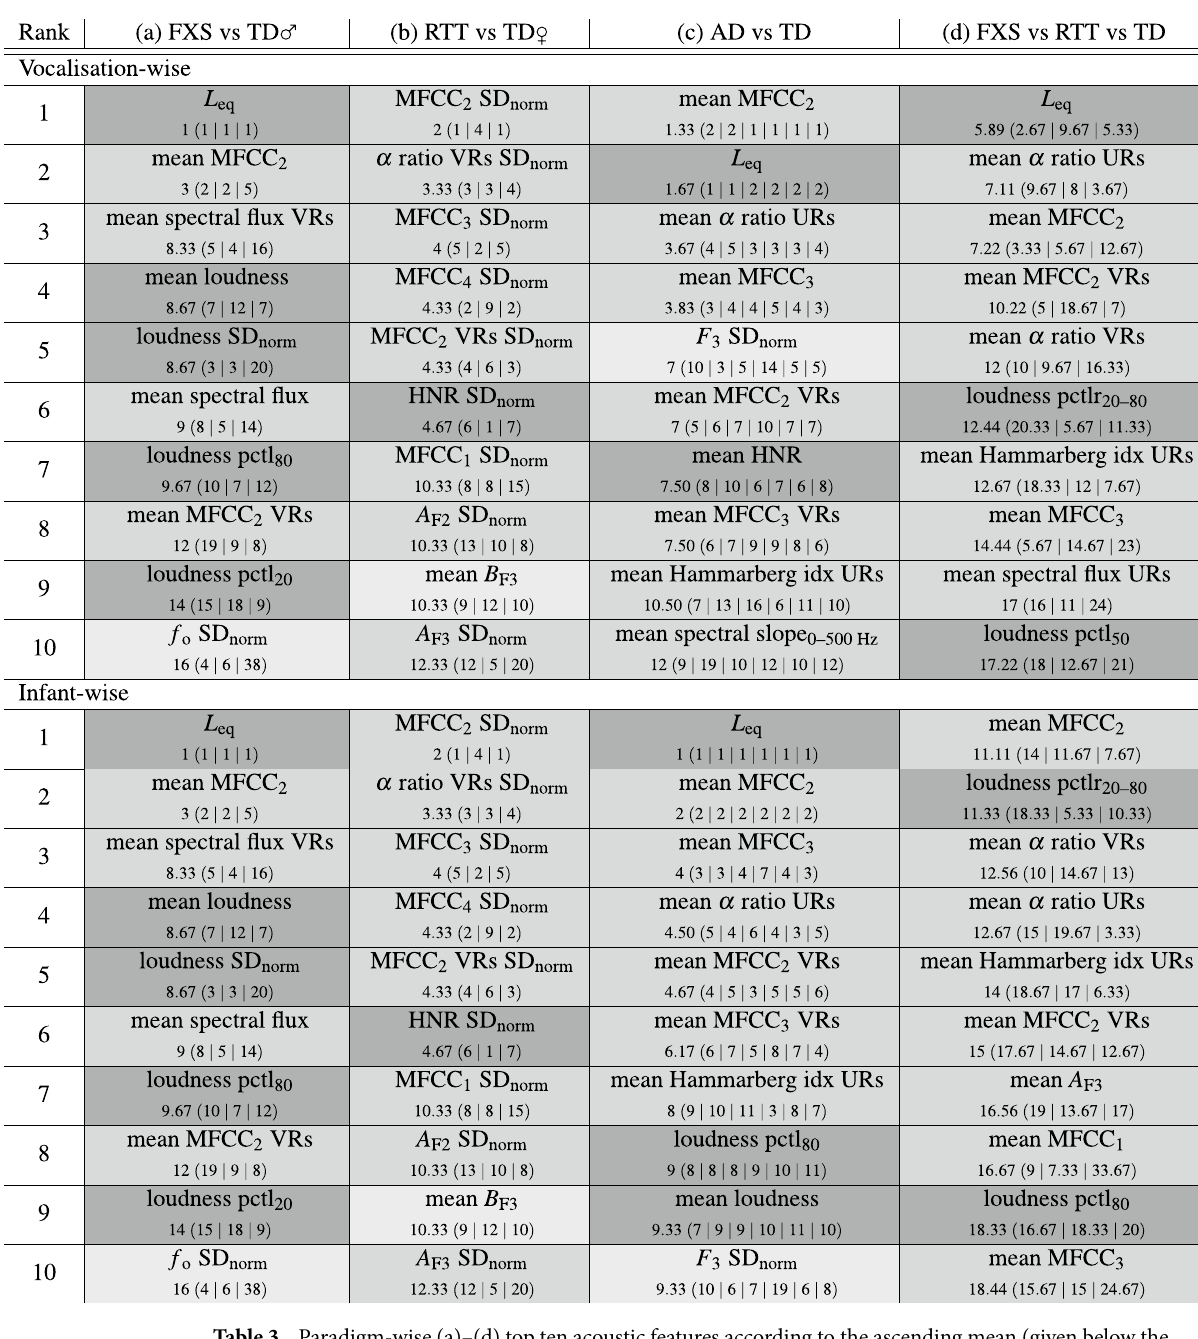
Table 3. Paradigm-wise (a)–(d) top ten acoustic features according to the ascending mean (given below the respective feature name outside the brackets) of cross-validation iteration-wise (mean of sub-models) feature ranks (given below the respective feature name within the brackets) for both vocalisation-wise and infant-wise evaluation scenario. Mean ranks are rounded to two decimal places. A, amplitude; AD, atypical development/ atypically developing; B, bandwidth; f o , fundamental frequency; F 2,3 , second and third vocal formant; FXS, fragile X syndrome; HNR, harmonics-to-noise ratio; idx, index; L eq , equivalent sound level; MFCC 1,2,3,4 , first, second, third, and fourth Mel-frequency cepstral coefficient; pctl, percentile; pctlr, percentile range; RTT, Rett syndrome; SD norm , standard deviation normalised by the arithmetic mean; TD, typical development; URs, unvoiced regions; VRs, voiced regions; ♀ , female; ♂ , male; colour code for features: light grey = frequency- related feature, middle grey = spectral/cepstral feature, dark grey = energy/amplitude-related